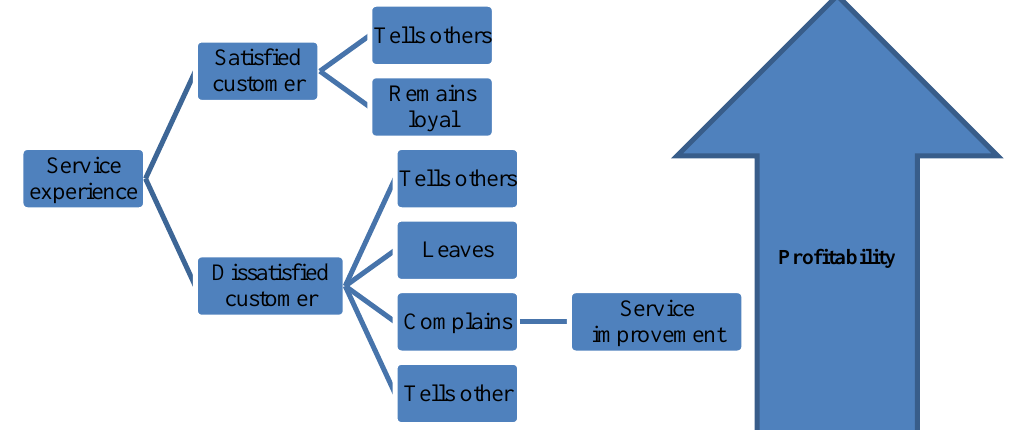
Fig. 1. Customer’s response in case of satisfaction or dissatisfaction (Leiks & Hekī, 2005, p.